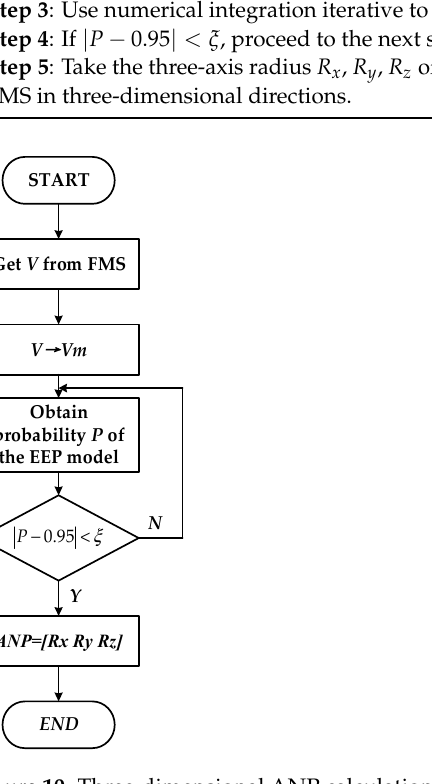
Figure 10. Three-dimensional ANP calculation process. Algorithm 1: Calculation process of three-dimensional ANP evaluation method